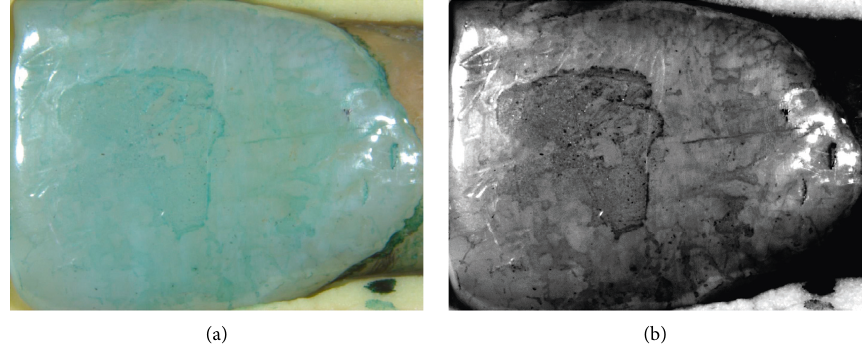
Figure 2: Adhesive remnant area analysis. (a) Green-stained tooth treated with nonfluorescent adhesive under white light; (b) image treated in Photoshop for better adhesive remnant identification.